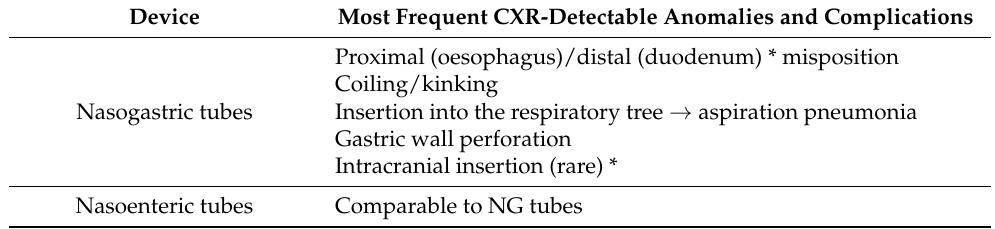
Figure 27. Image of a mispositioned NG tube, whose tip entered the left mainstem bronchus down to the left lower airways; prompt recognition of such misplacement avoided any sequelae for the patient. This CXR also shows a right jugular CVC and an ETT. Table 5. Intravascular devices’ most frequent CXR-detectable anomalies and complications. * Additional X-ray series/different imaging techniques may be required for detection.